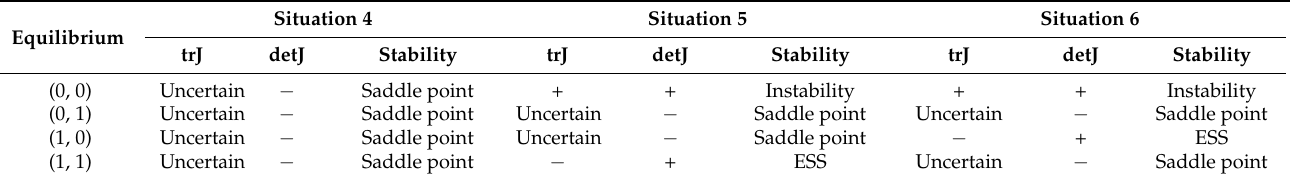
Table 4. Local stability of the equilibrium point (Situations 4, 5 and 6).